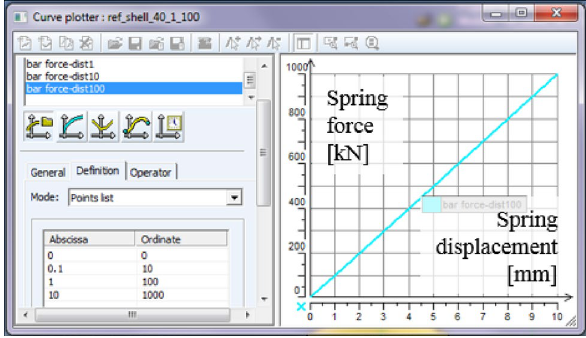
Fig. 8 Four stages of FE simulations